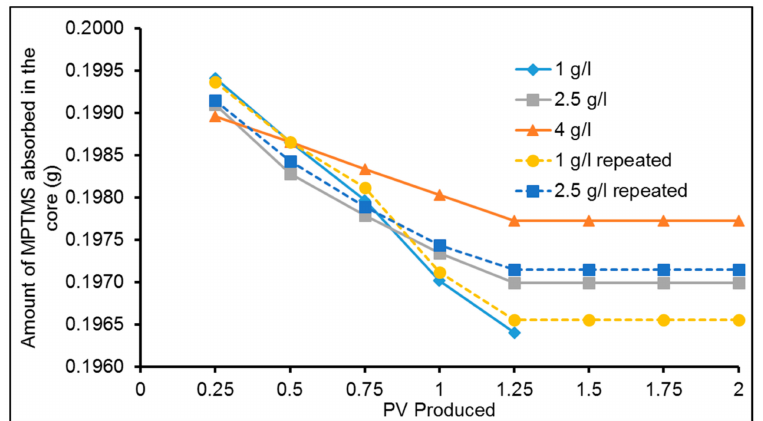
Figure 9. Absorbed MPTMS for cores saturated with nanofluid stabilized with MPTMS (Experiments: 4–8).